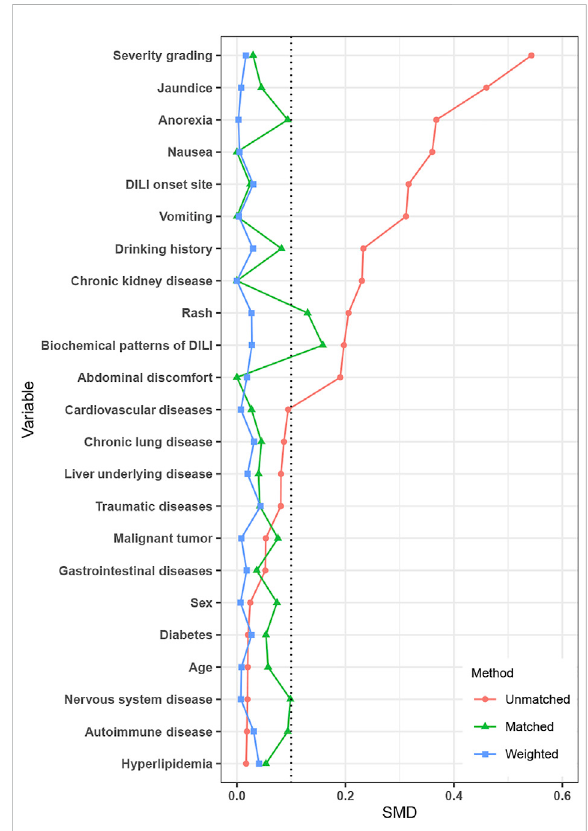
FIGURE 2 Standardized mean difference between the no PAC and PAC groupsinunmatched,PSM,andIPTWcohorts.Abbreviations:PAC, pharmacist active consultation; PSM, propensity score matching; and IPTW, inverse probability of treatment